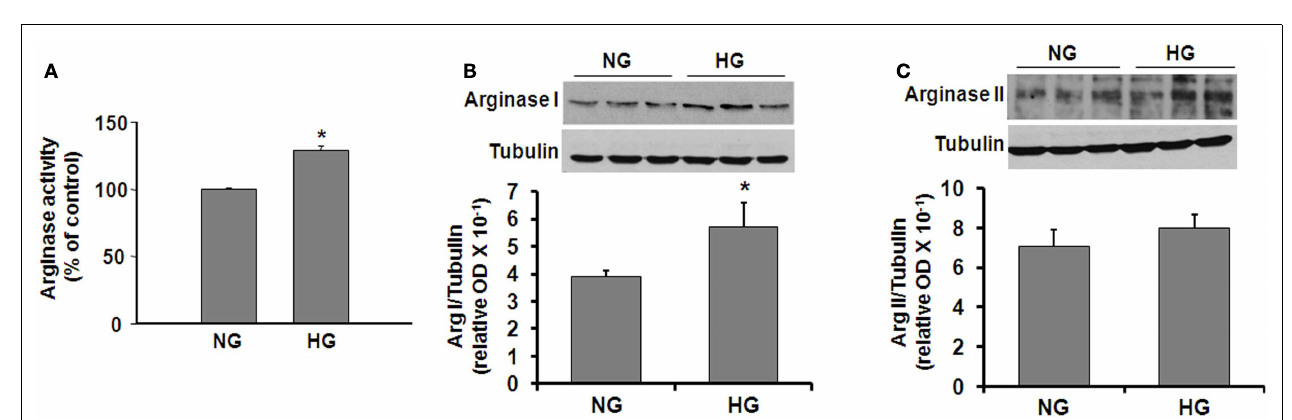
determined by arginase activity assay (* p < 0.05 compared with NG, n = 4). (B,C) Levels of arginase I and II protein were determined byWestern blot analysis ( n = 3–4) and quantified using ImageJ (* p < 0.05 compared with the NG